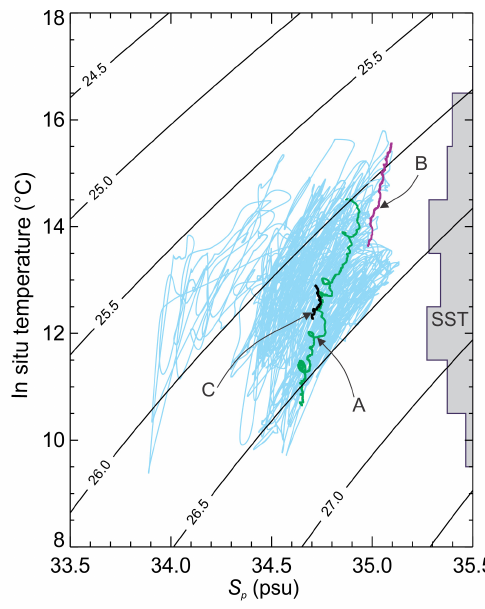
Figure 6. Temperature and salinity ( S p ) from the seabed sensors on the moorings with profile data overlain (see text for details) and σ T contours. The arbitrarily scaled histogram on the right-hand margin shows the distribution of satellite-derived sea surface temperature